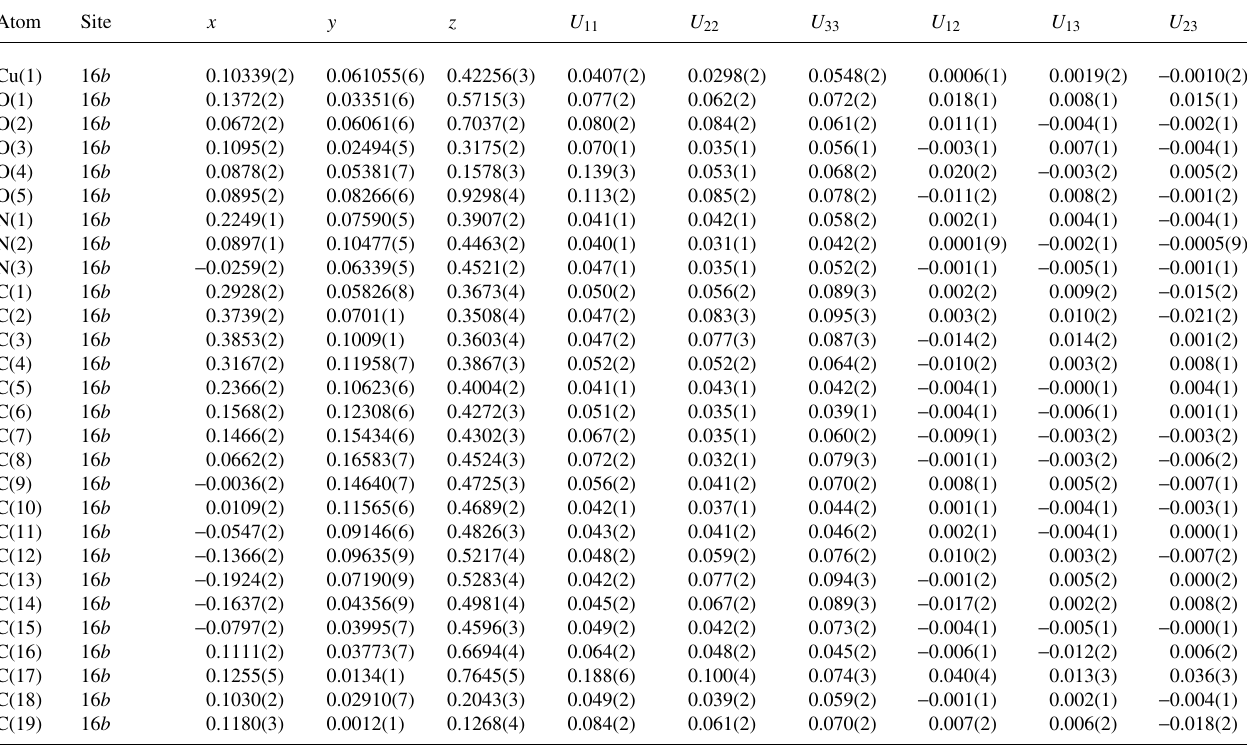
Table 3. Atomic coordinates and displacement parameters (in Å 2 ) .